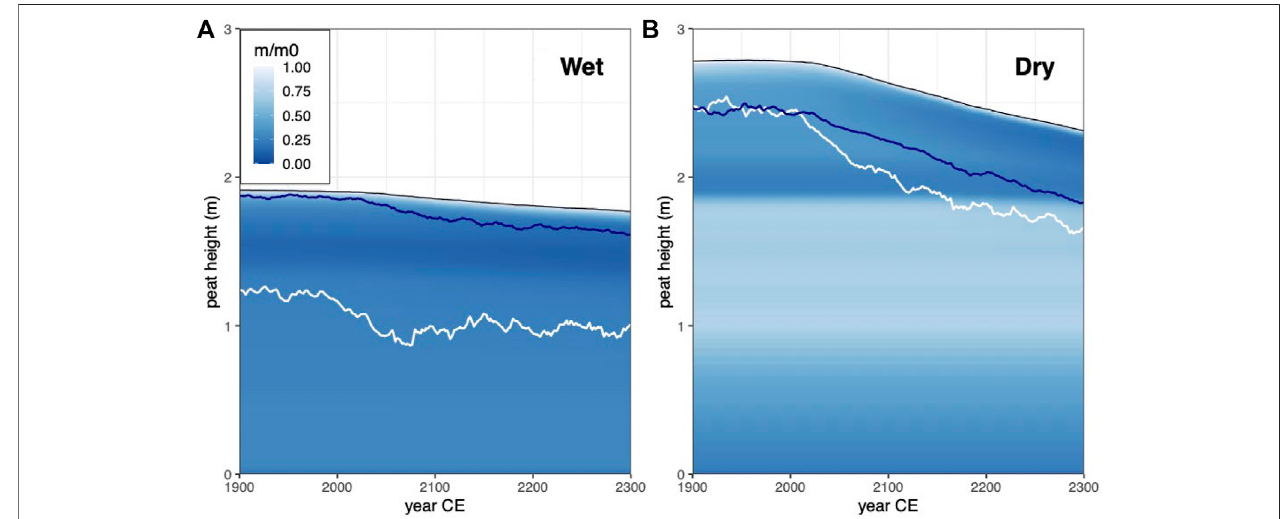
FIGURE 5 | Future projections of peat pro fi les at TKP under RCP8.5 using two different values of model parameter for the height when run-on switches to run-off (H run-on/off ): (A) H run-on/off = 4.5 results in a wetter peat pro fi le with a water table (blue line) near the peat surface; (B) H run-on/off = 0.5 results in a drier peat pro fi le and an unsaturated active layer. All other parameters and climate drivers were the same between the two simulations. The white line represents top of permafrost; m/m0 represents the peat litter cohort mass remaining, high values indicating relatively undecomposed peat.